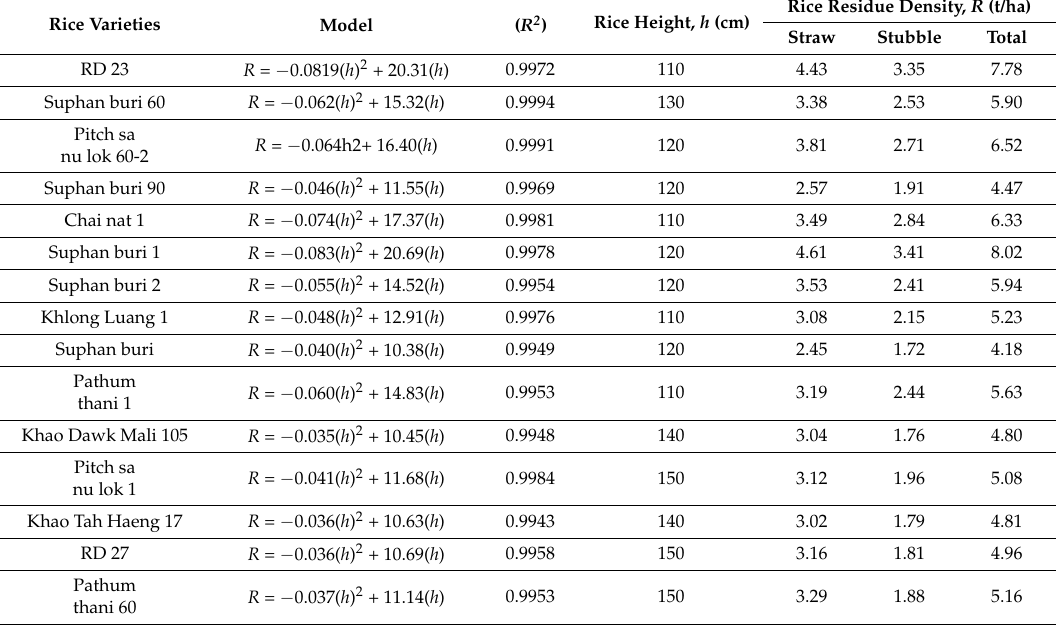
Table 1. Relationship between the mass and height of rice plant and rice residue density classified by rice